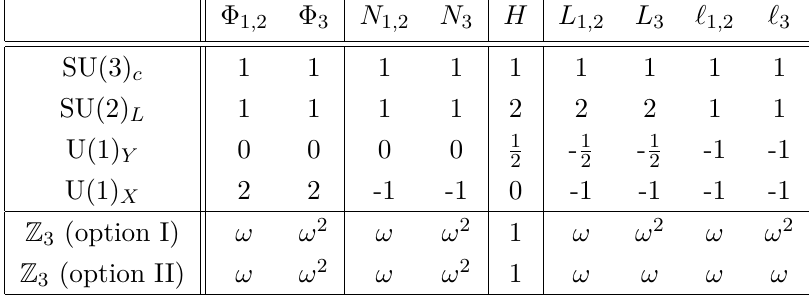
Table 1 . Field content of the model, for X = B − L . We give two optional charge assignments for the discrete Z 3 family symmetry ( ω = e 2 iπ/ 3 ), differing only for L 3 and ‘ 3